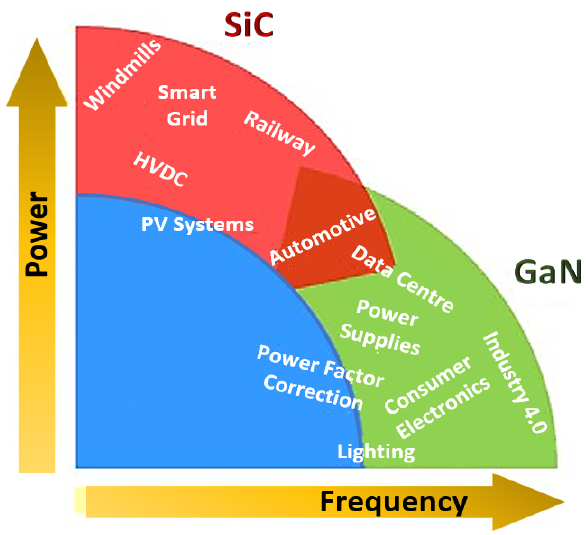
Figure 5. Comparison of the applications of Si, SiC, and GaN power devices [27].